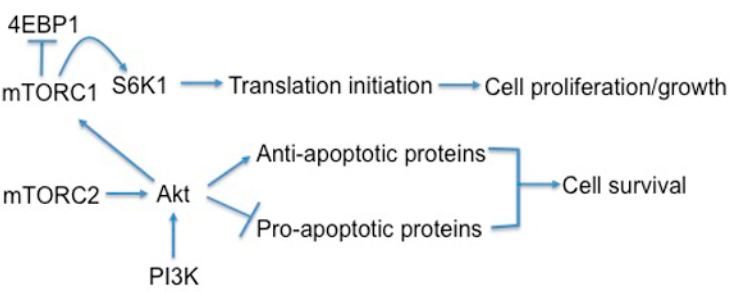
Figure 4. mTOR regulates cell growth, proliferation, and survival. The arrows indicates positive regulation while the symbol T indicates the inhibition of the target molecule(s).